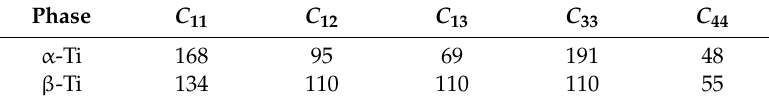
Table 2. Stiffness coefficient C ij /GPa of α -Ti phase and β -Ti